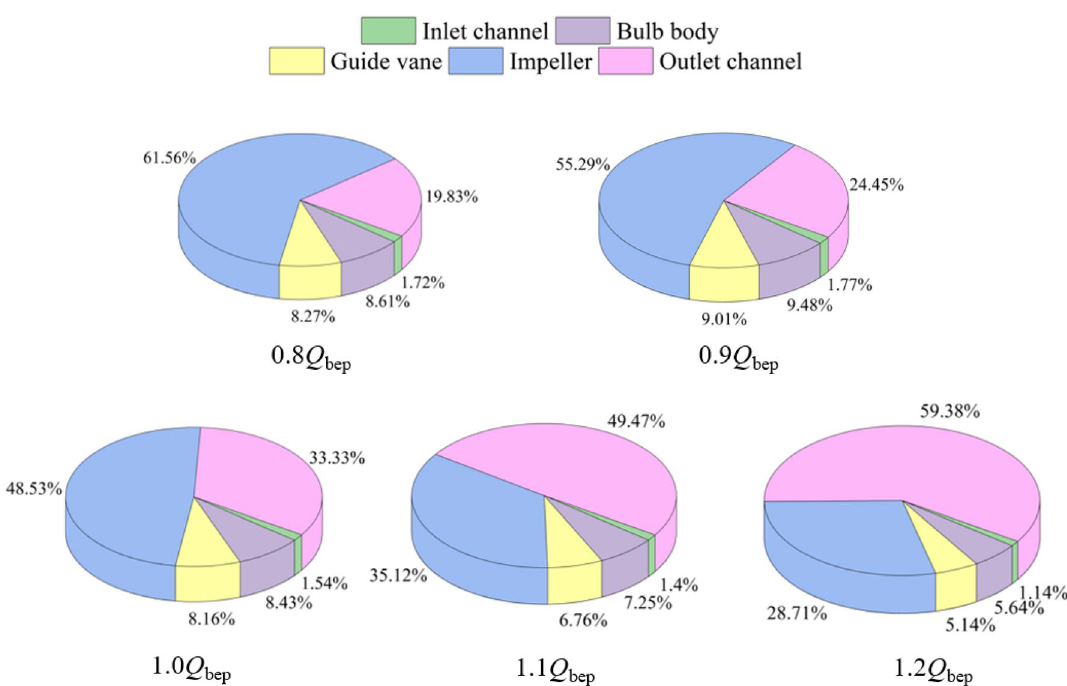
Figure 7. Distribution of the entropy production ratio in each region of the system under different flow